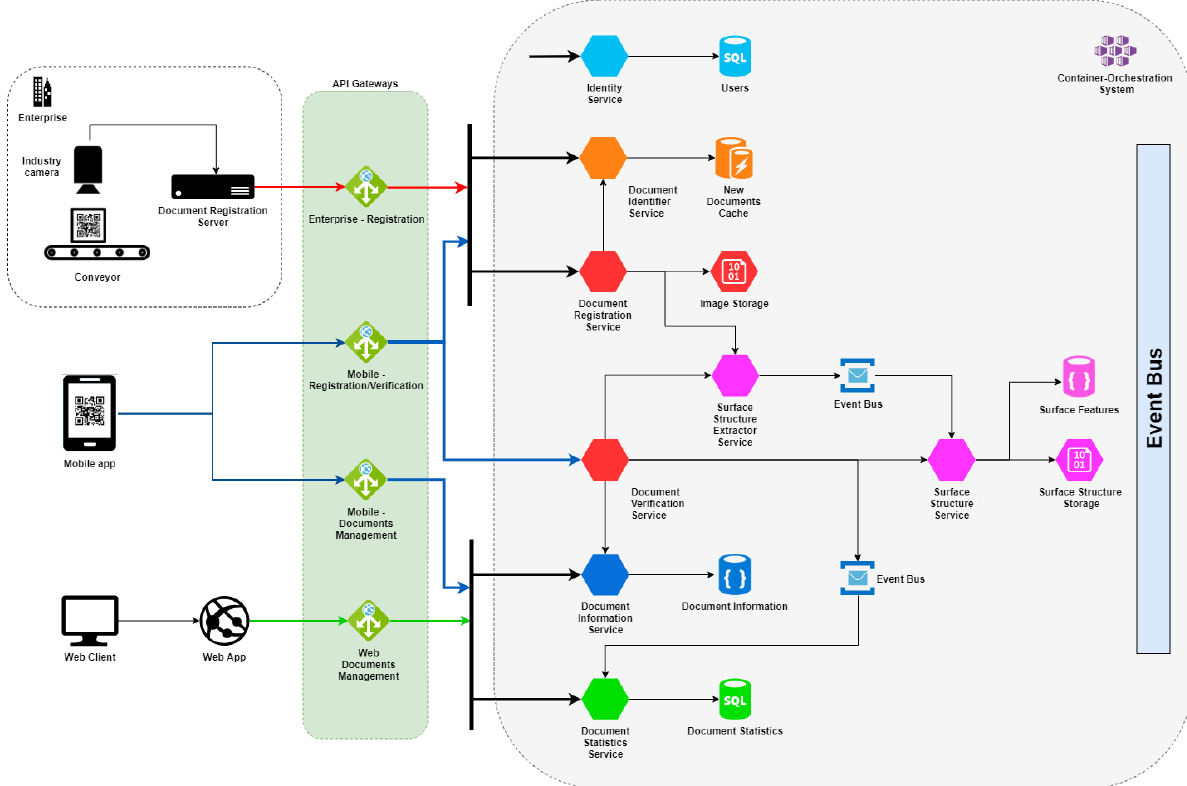
Figure 6. Microservice based architecture of paper document counterfeit detection